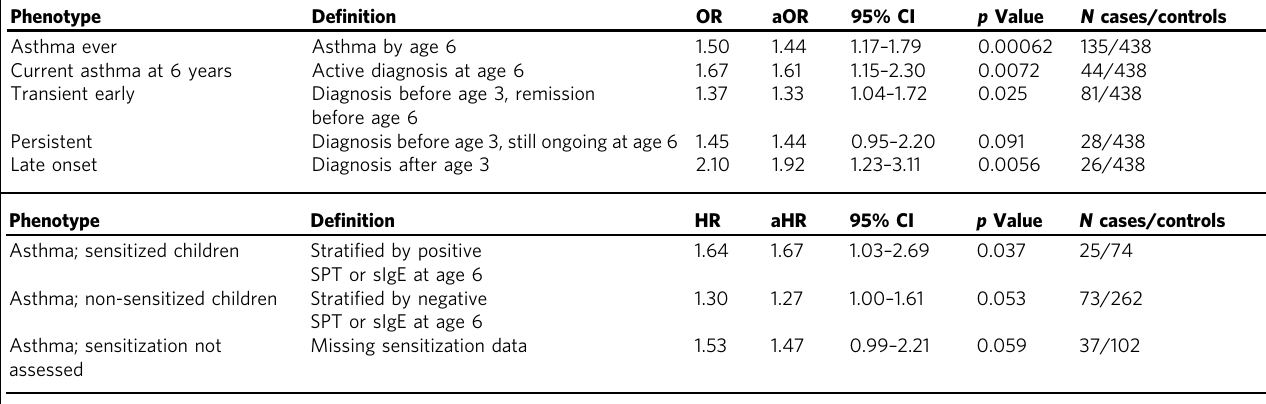
OR odds ratio, CI con fi dence interval, HR hazard ratio, SPT skin prick test, sIgE speci fi c immunoglobulin E Estimatesfrom logistic regression(OR, CI) or Cox proportional hazards regression (HR) between the bacterial asthma scoreand asthma, accordingto age-dependent phenotypeand allergic sensitization status to inhalant allergens (SPT, sIgE). Crude and adjusted (aOR/aHR) estimates provided, after adjustment for season of birth, paternal asthma, and siblings in the home. Con fi dence intervals and p values pertain to adjusted analyses. We found no evidence of an interaction effect between the bacterial asthma score and allergic sensitization ( p = 0.36)